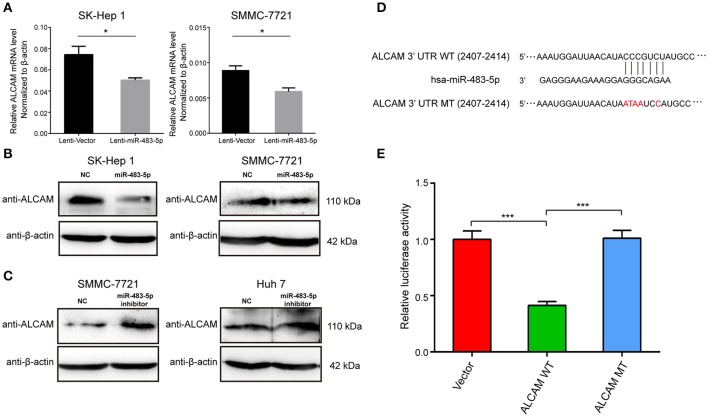
miR-483-5p post-transcriptionally downregulates ALCAM expression by directly targeting its 3′-UTR. (A) ALCAM mRNA levels were repressed by miR-483-5p in HCC cells. (B) ALCAM protein levels were repressed by miR-483-5p mimics in HCC cells. (C) ALCAM protein levels were up-regulated in HCC cells with miR-483-5p inhibitor. (D) Diagram of putative miR-483-5p binding sites in the 3′-UTR of ALCAM. The mutant sequences ALCAM 3′-UTR used in the luciferase reporter constructs are indicated in red. (E) Relative activities of luciferase reporters containing ALCAM 3′-UTR variants co-transfected with miR-483-5p or negative control mimics in HEK 293T cells. *p < 0.05; ***p < 0.001.